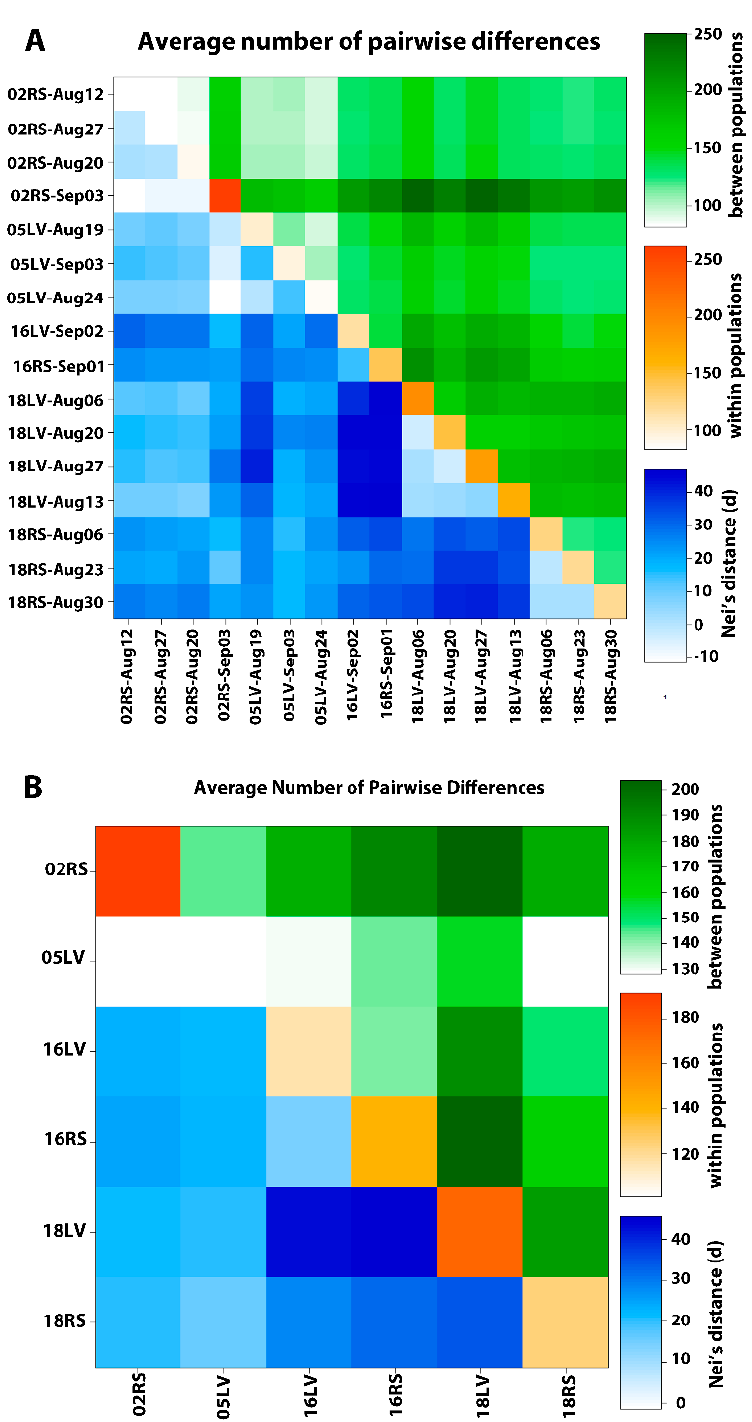
Figure 3. Average pairwise di ff erences between populations (above diagonal), within each population (diagonal) and Nei’s genetic distances (55) between populations (below diagonal) of H. zea samples partitioned by collection date within each year ( A ) and pooled by collection year and collection site ( B ) for populations from Landisville (LV) and Rock Springs (RS), PA. Putative population names use the convention of two-digit collection year (02, 05, 16 or 18) and two letter collection site code. Samples partitioned by collection date within year are also indicated by three-letter month code and the date. Increasing intensity of colors indicate increasing number of di ff erences. Corresponding data are provided in Supplementary Data Tables S10a,b.